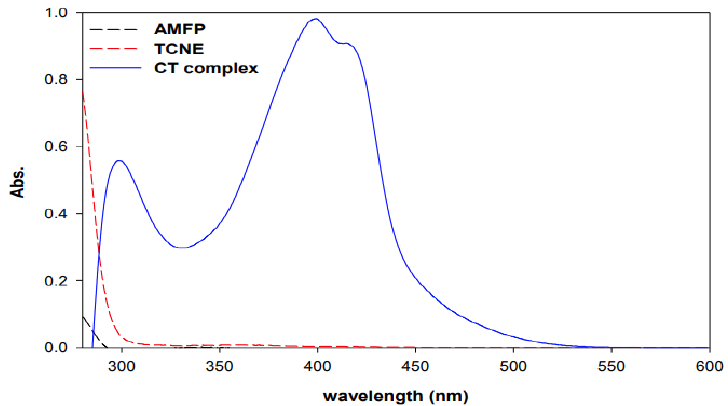
Figure 2. Electronic spectra of 1.0 × 10 − 4 mol L − 1 AMFP, 1.0 × 10 − 4 mol L − 1 TCNE, and (1:1) AMFP–TCNE CT complex in DCE.